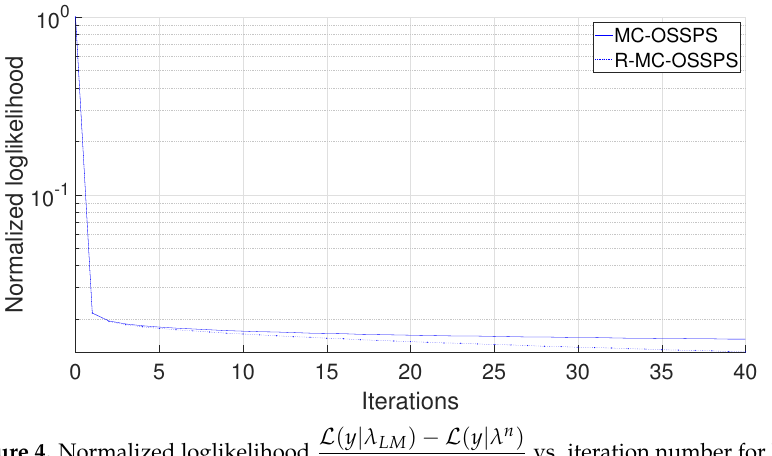
Figure 4. Normalized loglikelihood MC-OSSPS. Note that the y -axis is in logarithmic